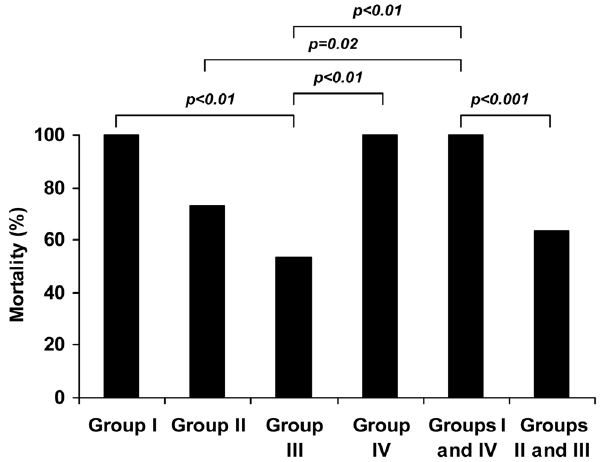
Figure 1. Mortality observed in rats with cirrhosis and induced bacterial peritonitis during one week after E.coli inoculation. Group I: placebo (serum s.c.); Group II: ceftriaxone s.c.; Group III: anti- TNF- a mAb i.p. + ceftriaxone s.c.; Group IV: anti-TNF- a mAb i.p.; Groups I and IV (non-antibiotic treated rats) and Groups II and III (antibiotic treated